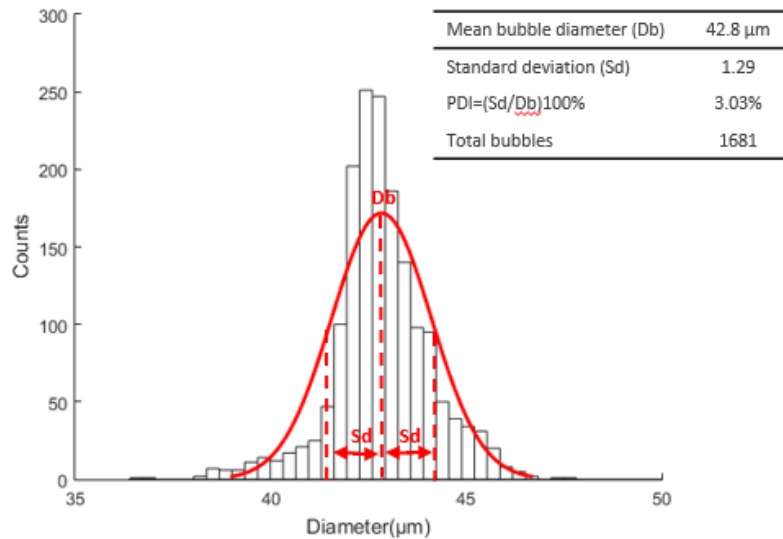
Figure 15. Microbubble diameter distribution curve with a mean diameter, standard deviation, and PDI of 42.7 µ m, 1.42, and 3.32%, respectively.